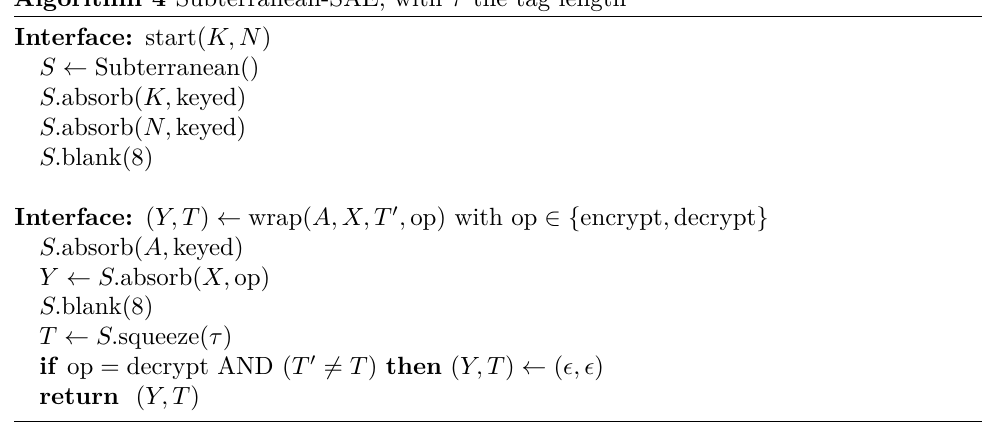
Algorithm 4 Subterranean-SAE, with τ the tag